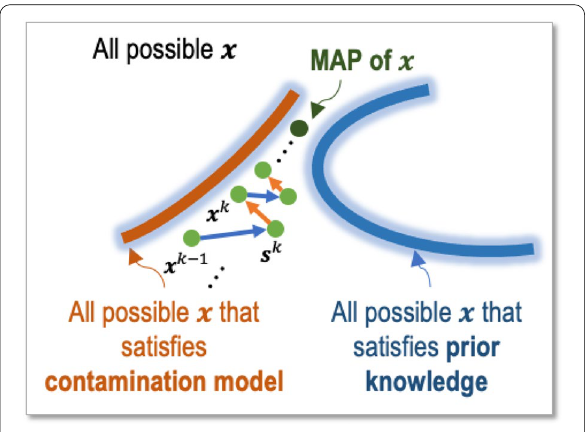
Figure 4 Illustration of MAP estimation